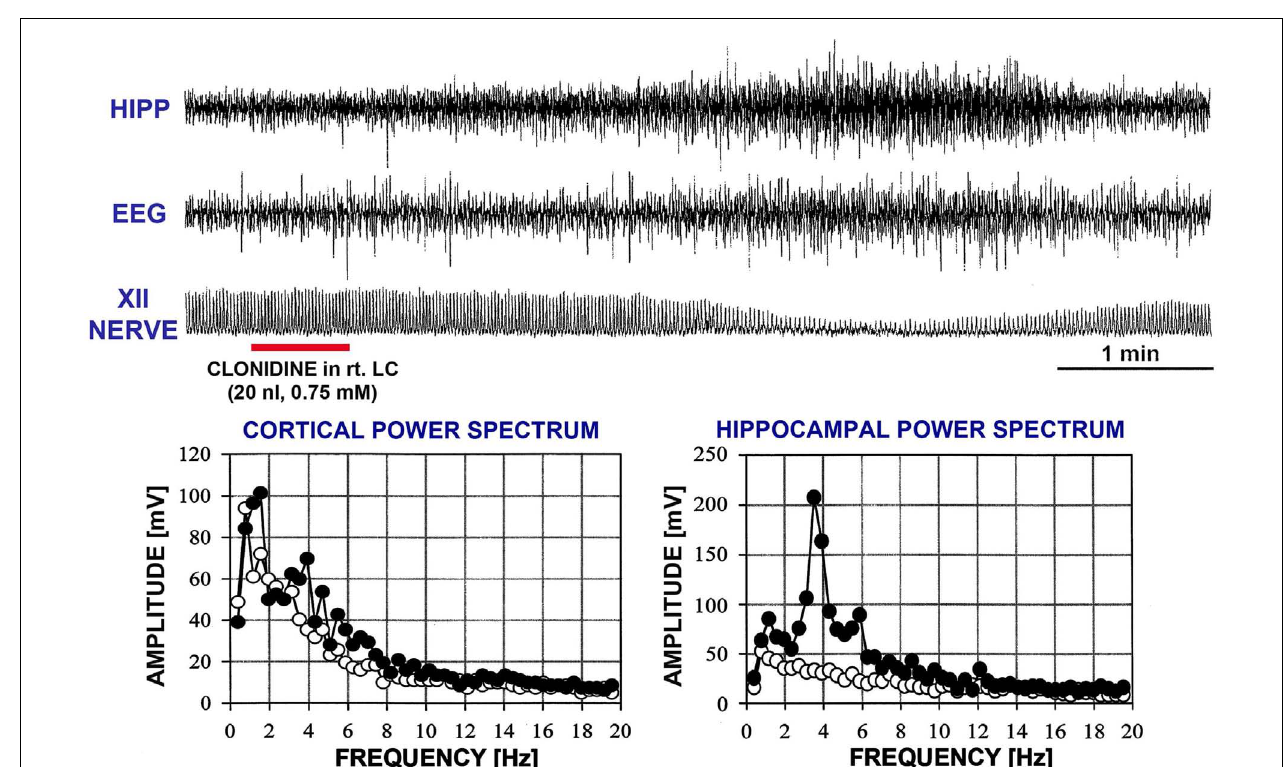
elicited here by clonidine to those elicited by carbachol and illustrated in Figure 3 .The power spectra for the control period and the period centered on the peak of the response are shown with open and filled circles, respectively.